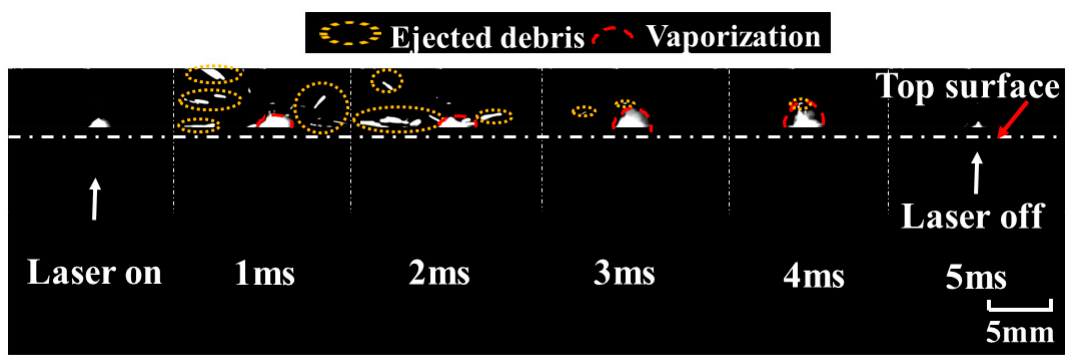
Figure 10. Ejection and vaporization behavior with a pulse width of 5 ms during single-pulse laser drilling at a peak power of 500 drilling at a peak power of 500 W.